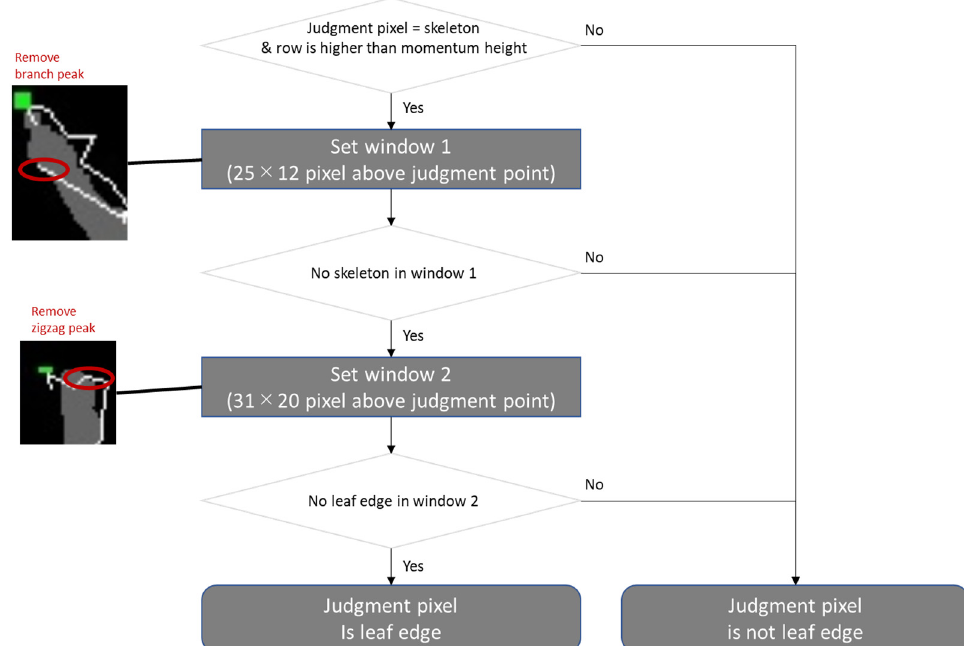
Figure 6. Flowchart of the peak-in-window method.